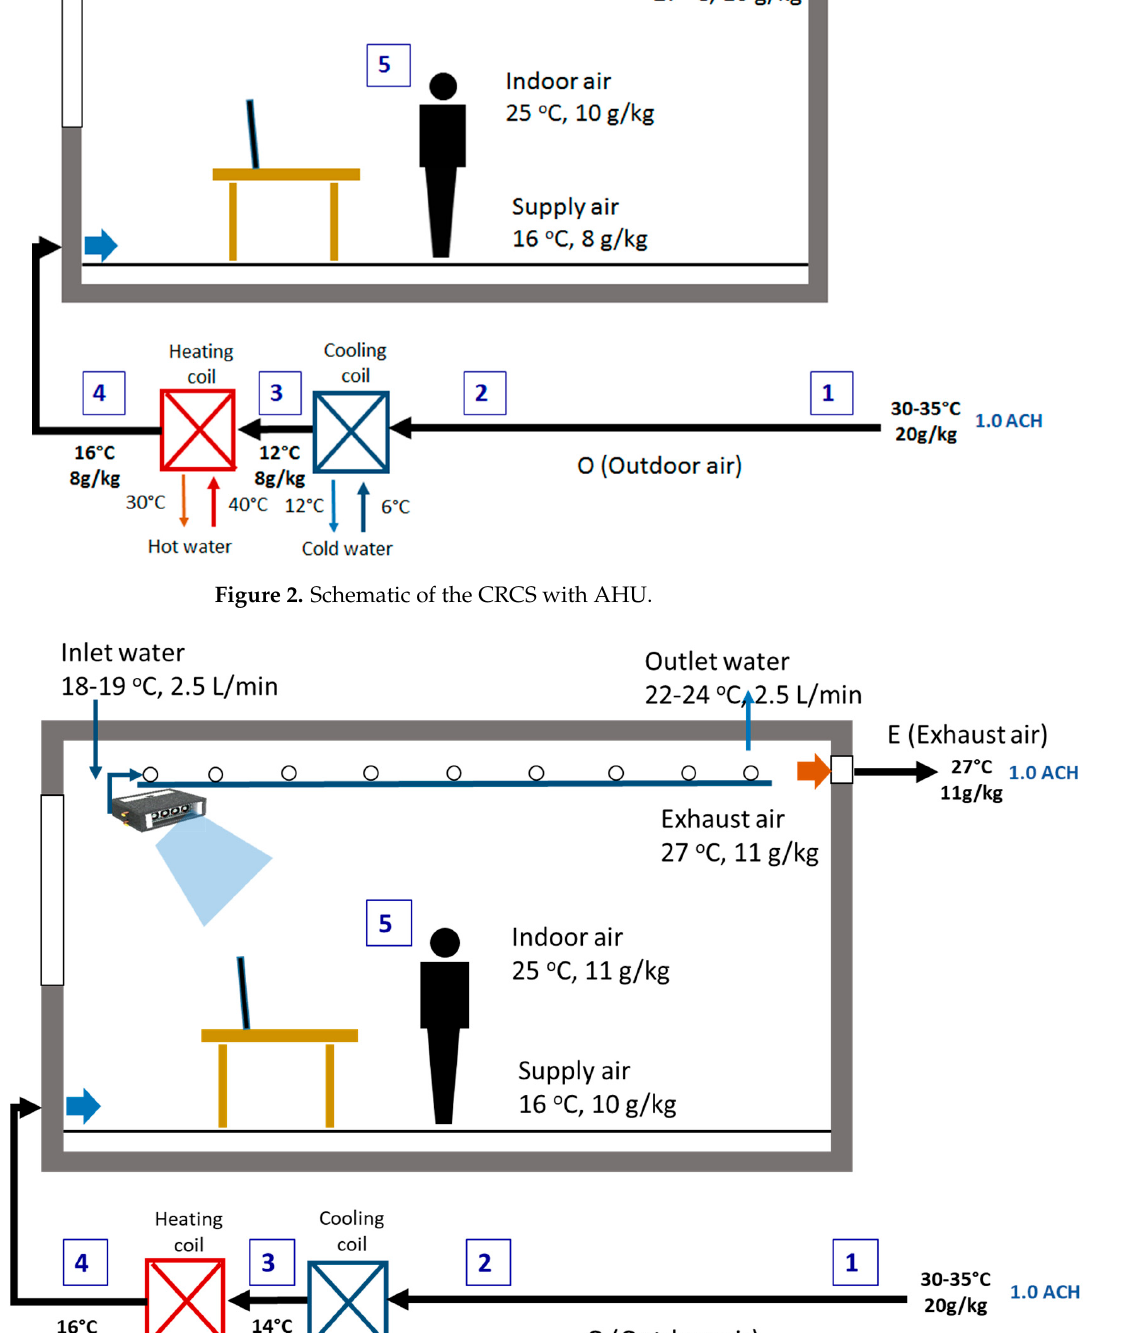
Figure 4. Psychrometric of the AAS, CRCS, and HRCS system . 2.2. Weather and Building Characteristics as Case Studies in China This study selected four local China weather conditions, Beijing (northern China), Shanghai (southeastern China), Chengdu (northwestern China), and Guangzhou (south- ern China), to investigate the acceptable performance for the operation of AAS, CRCS, and HRCS in the hot and humid summer season. Beijing, the capital city of China, is lo- cated in northern China, and it has hot and humid summer conditions due to East Asian monsoons. Shanghai is located in the Yangtze River in southeastern China and shows a